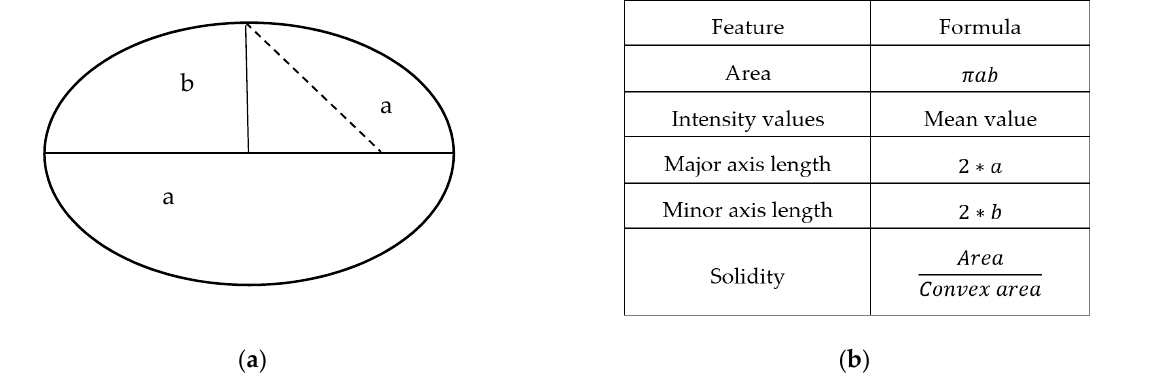
Figure 10. ( a ) Sample diagram of calculation formula for extracted features. ( b ) Shape-based features and their equations.